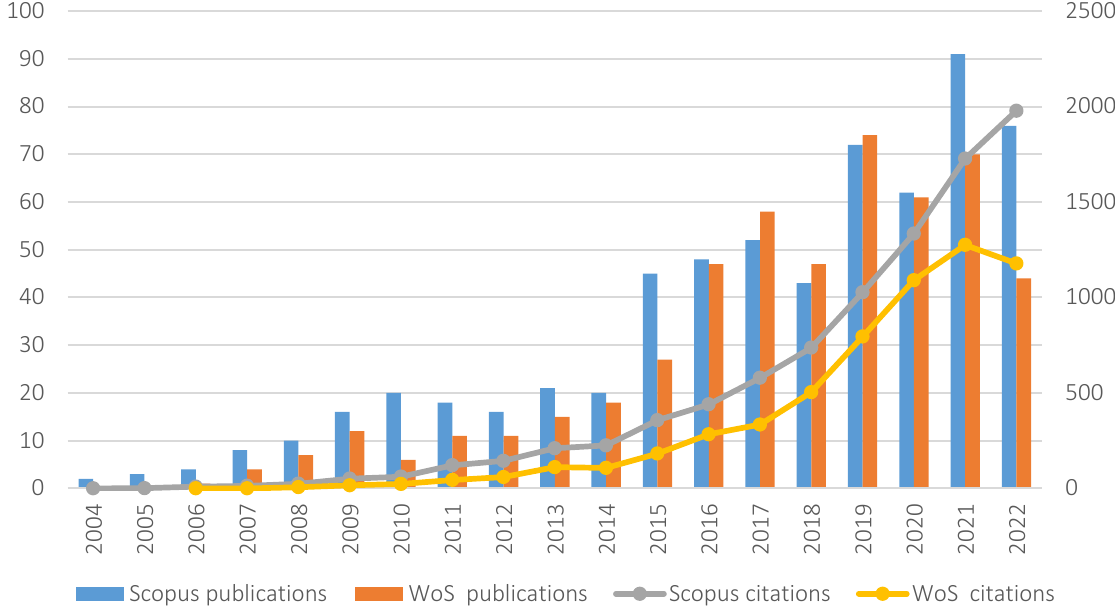
Figure 1. Dynamic analysis of the number of publications and citations on the third mission of a university in Scopus and WoS databases for